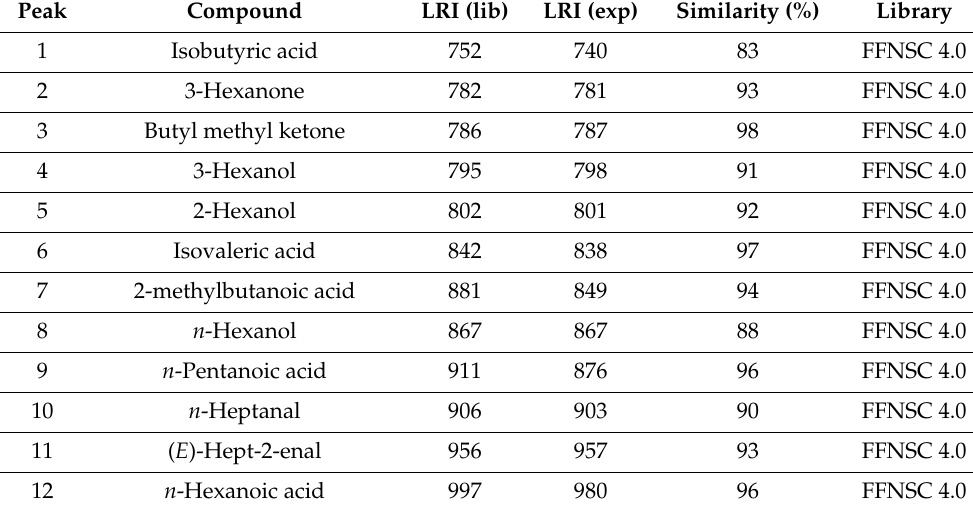
Figure 1. GC-MS profile of the n -hexane fraction of Z. lotus. Main peaks are labeled. Peak assignment as in Table 4. Table 4. List of compounds identified in Z. lotus by GC-MS.